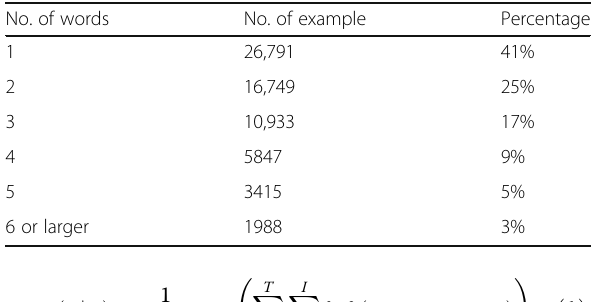
Table 5 Statistics on the lengths of